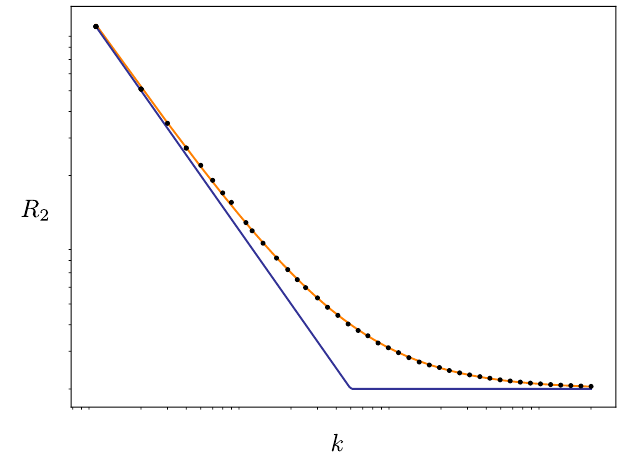
50 , showing (3.10) (black dots) and the planar (cid:16)